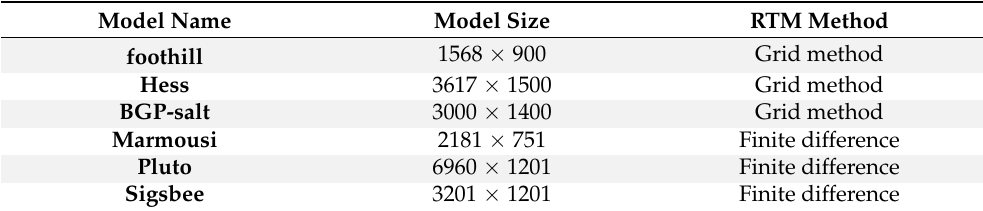
Table 1. The properties of the training datasets. There were 6 models (foothill, Hess, BGP-salt, Marmousi, Pluto, and Sigsbee) in the dataset. The first 5 models were used as the training dataset, and the Sigsbee model was used as the validation